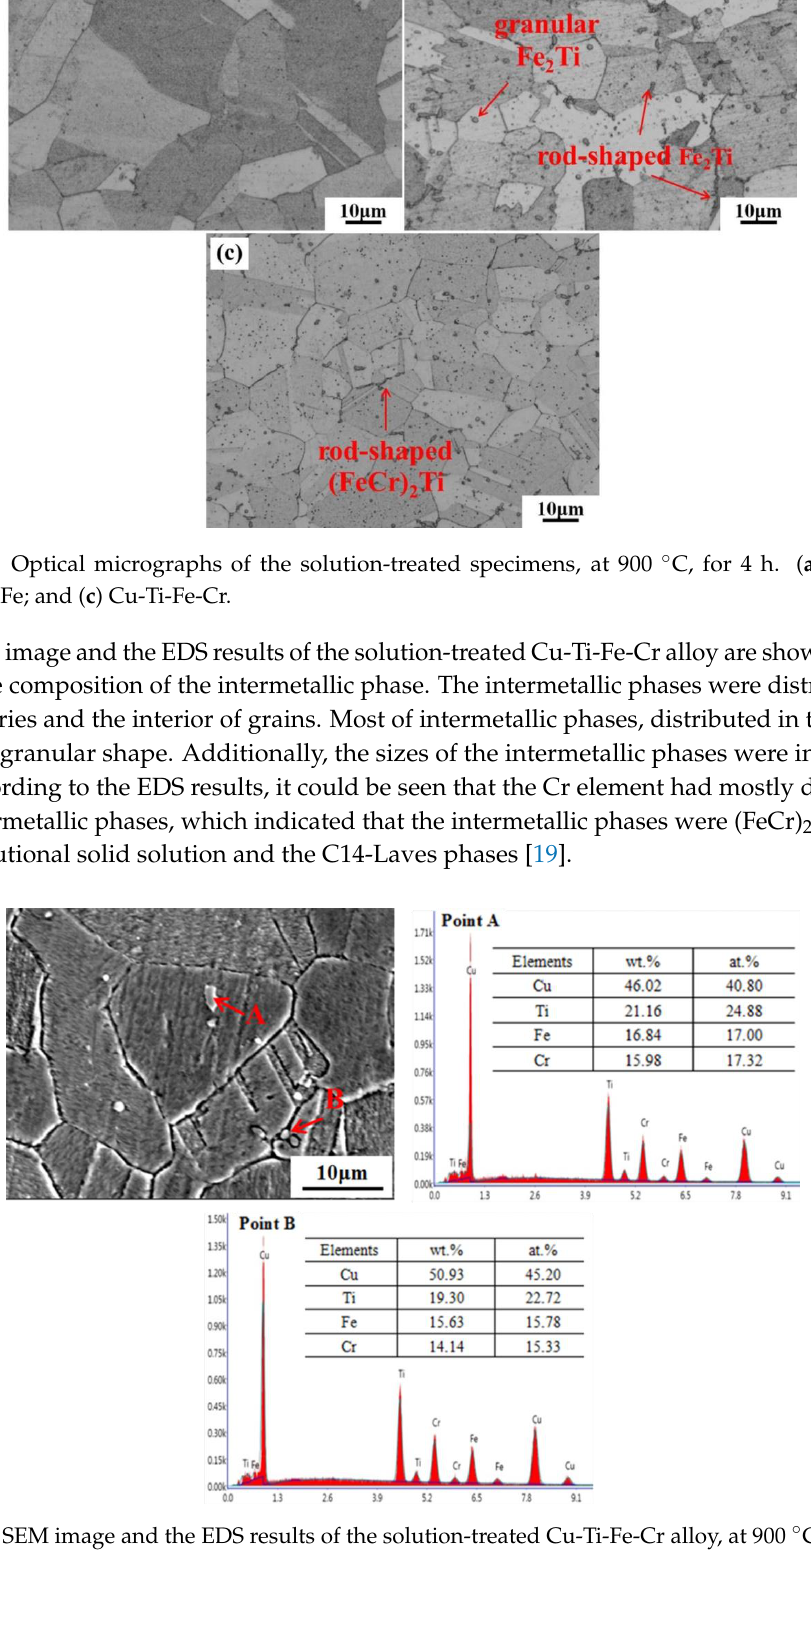
Figure 2 . SEM image and the EDS results of the solution-treated Cu-Ti-Fe-Cr alloy, at 900 °C, for 4 h.